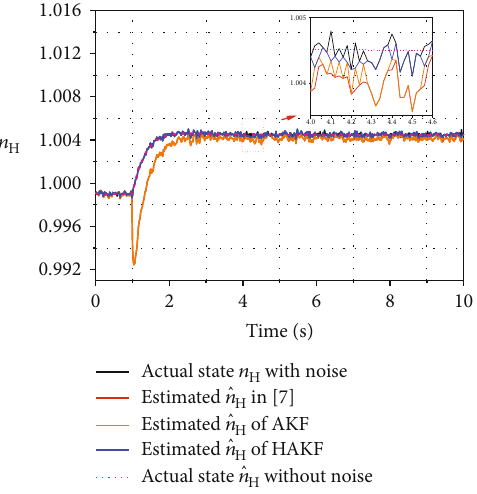
Figure 11: State n H and its estimations of three methods.